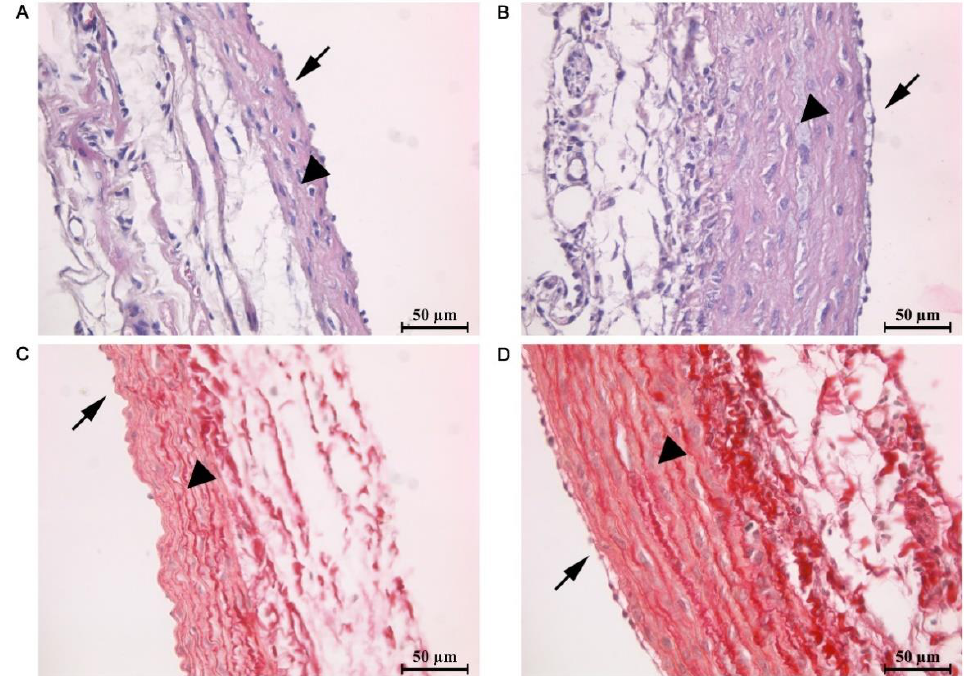
Figure 1. Representative microphotographs of pulmonary trunk cross-sections in control rats ( A , C ) and rats with the experimental model of pulmonary hypertension ( B , D ). ( A , C ) Staining by hematoxylin and eosin (H&E). ( B , D ) Staining by Picrosirius Red. All images were obtained with 40 × magnification. Arrowheads indicate the increased tunica media thickness in the MCT rats; arrows show tunica intima with endothelial cells.